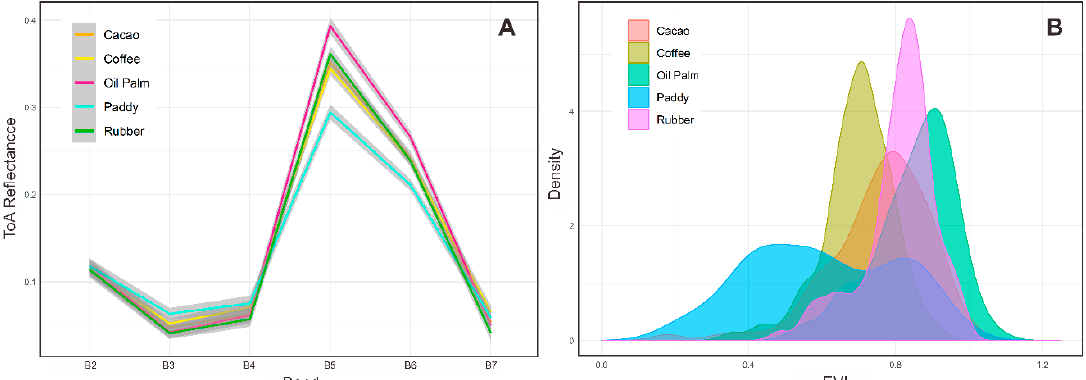
Figure 4. Spectral signature of commodity maps. ( A ) Vertical axis represents top of atmosphere reflectance of Landsat 8 of 2019, while the horizontal axis represents the multispectral band used for classification and ( B ) Probability density function for enhanced vegetation index (EVI) of commodity maps. The histogram shows the performance either multispectral of the imageries or vegetation index (EVI) to distinguish the characteristics of five commodities.